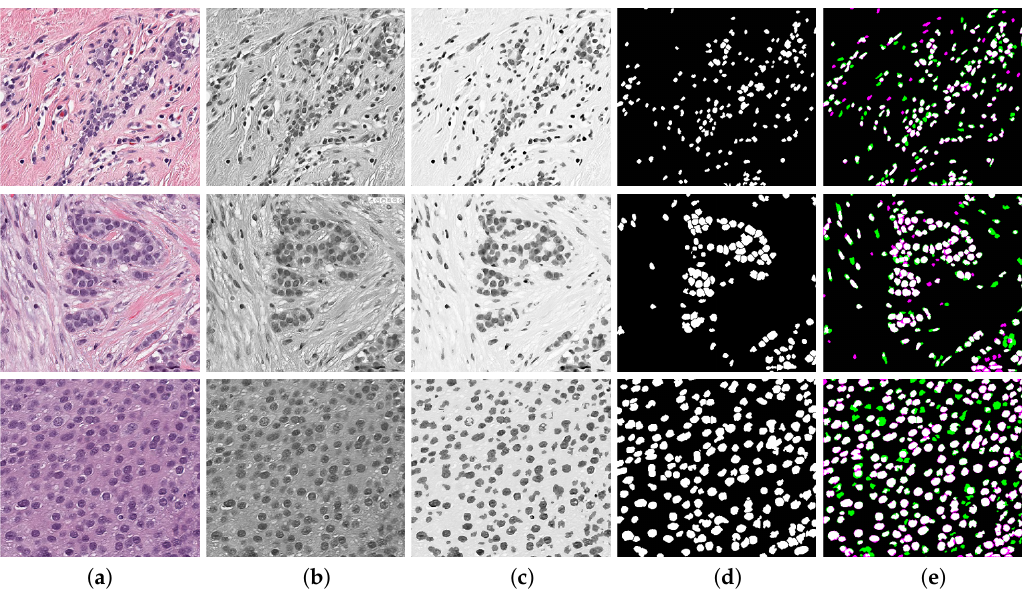
Figure 4. Enhancement of nuclei area. First row corresponds to a Tumour Cellularity (TC) value of zero, second row is an example of TC = 0.5 and third row is TC = 1. Images in column ( a ) are the original image, ( b ) gray level images, ( c ) enhanced images, notice that the nuclei region is darker whilst background becomes lighter, ( d ) Binary image obtained with an adaptive threshold value estimated directly from strongest correlated parameter, and ( e ) validation of nuclei segmentation by Jaccard index. Reference image was manually segmented by using QuPath